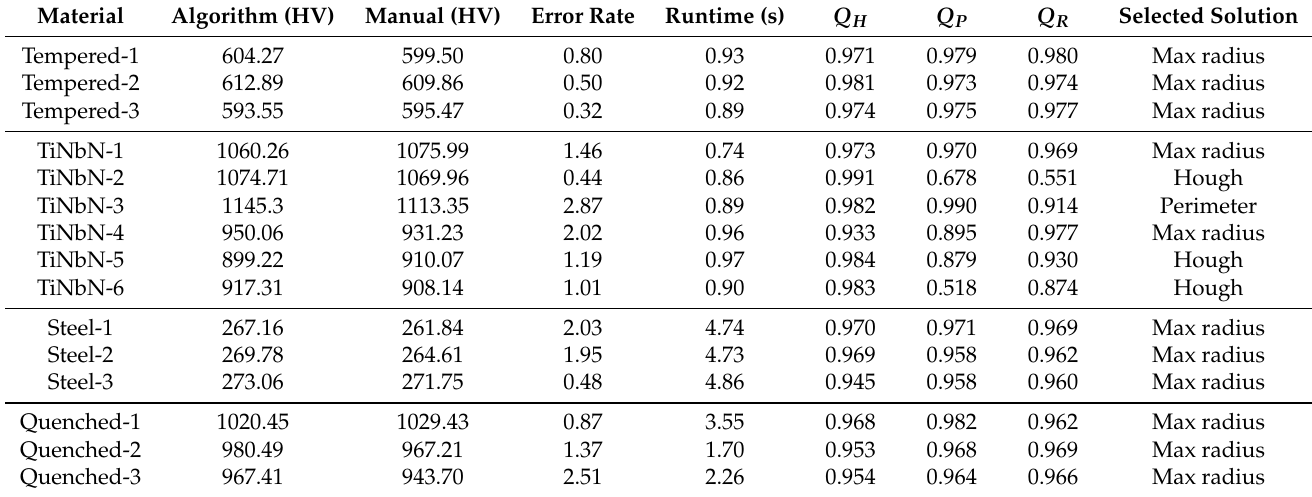
Table 2. Vickers hardness results with 10N applied force, where “Steel” corresponds to steel in its initial state, Q H to the quadrature index of the solution by Hough, Q P to the quadrature index of the solution by Perimeter and Q R to the quadrature index of the Local Maximum